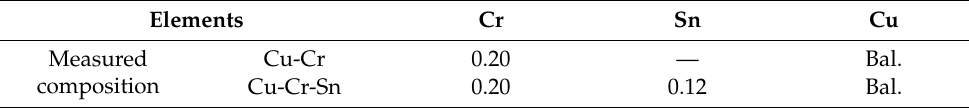
Table 1. The chemical compositions of Cu-Cr and Cu-Cr-Sn alloys (wt.%). Elements Cr Sn Cu Measured Cu-Cr 0.20 — composition Cu-Cr-Sn 0.20